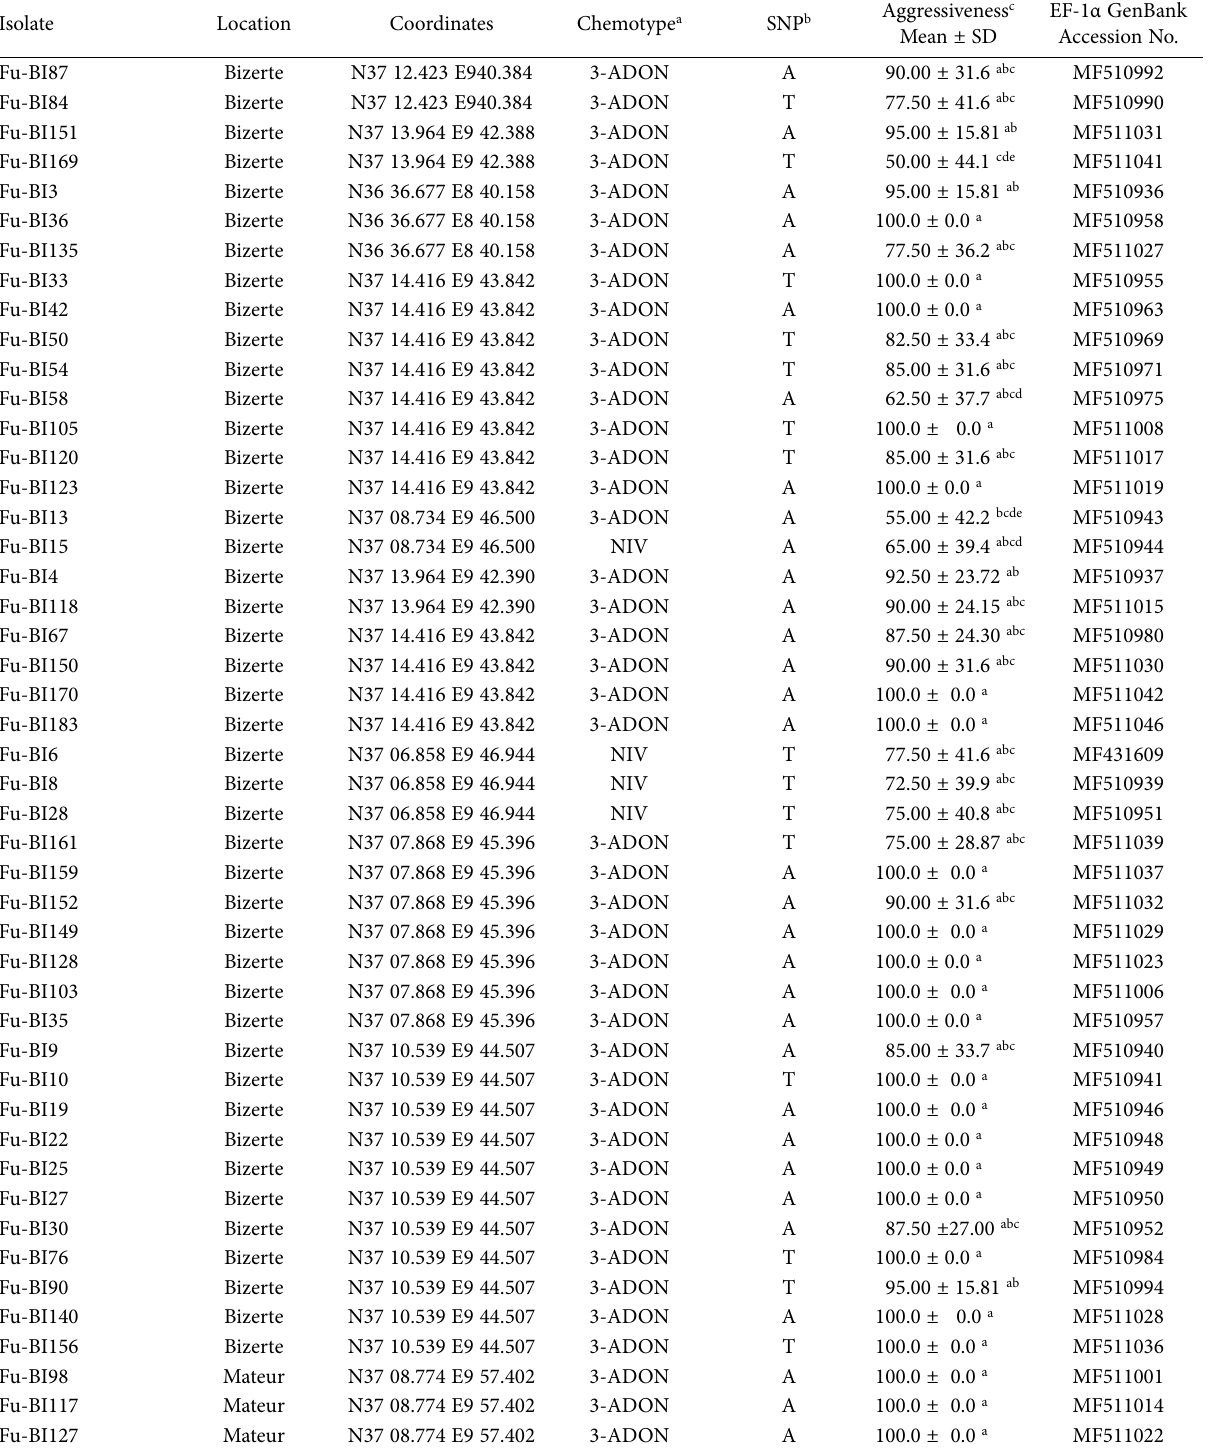
Table 1. Locations, chemotypes, Single nucleotide polymorphisims (SNP), mean aggressiveness scores and GenBank accession numbers for Fusarium isolates associated with Fusarium root rot of wheat in